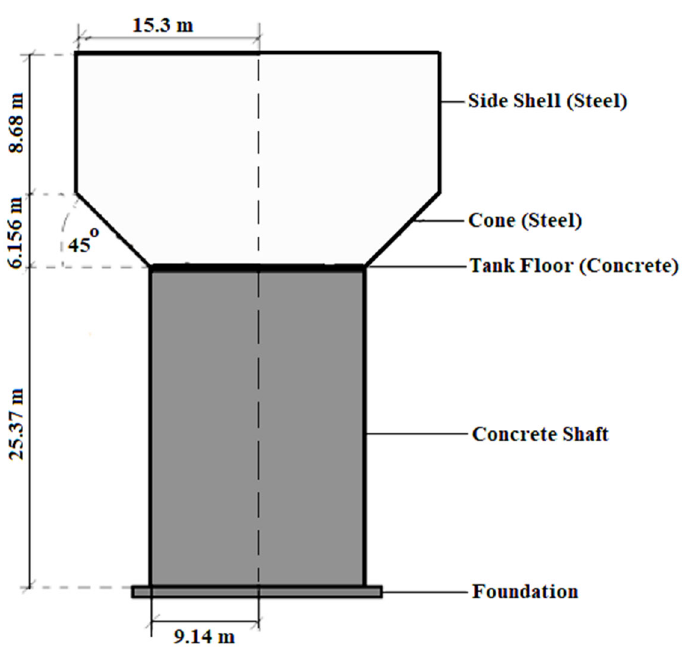
Figure 4. Geometric properties of the elevated concrete tank.